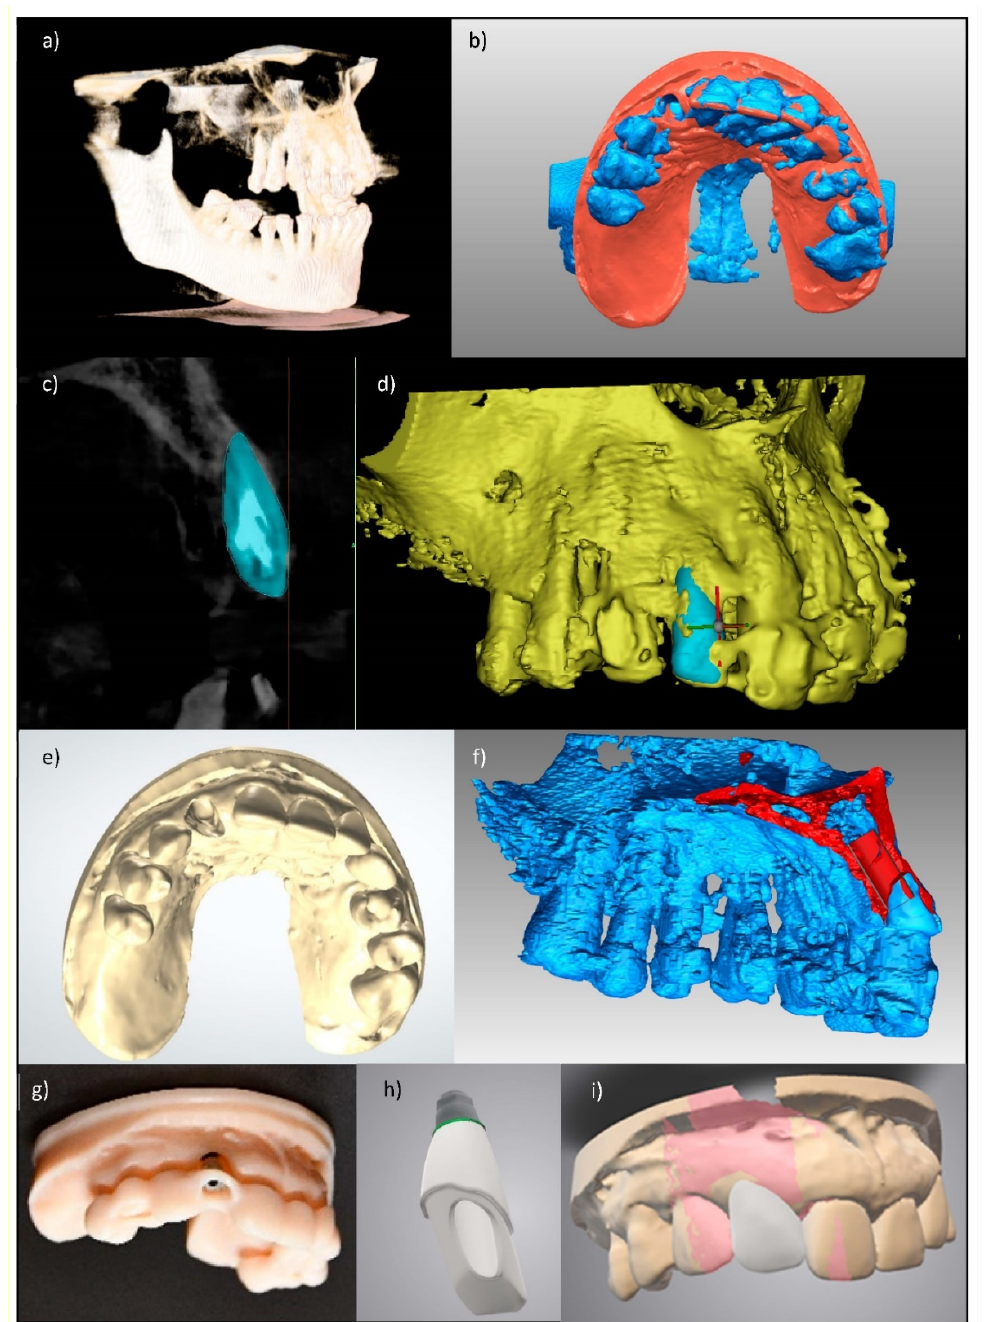
Figure 16. Description of the procedure for manufacturing prosthetic components and the surgical guide for the procedure of immediate prosthetic reconstruction using SLA technology for the production of implant and numerically controlled machining centers (CNC) for prosthetic components. (a) 3D tomogram of the patient obtained in the CBCT tomography; (b) 3D digital model, the bone base models and intraoral scans; (c) separated model of the tooth which will be removed; (d) assembled model with the tooth which will be removed; (e) virtual model of the situation after the removal of the tooth; (f) the optimal location of the implant in the alveolus; (g) design of the implant guide; (h) design of an individual abutment; (i) the design of the PMMA temporary crown.